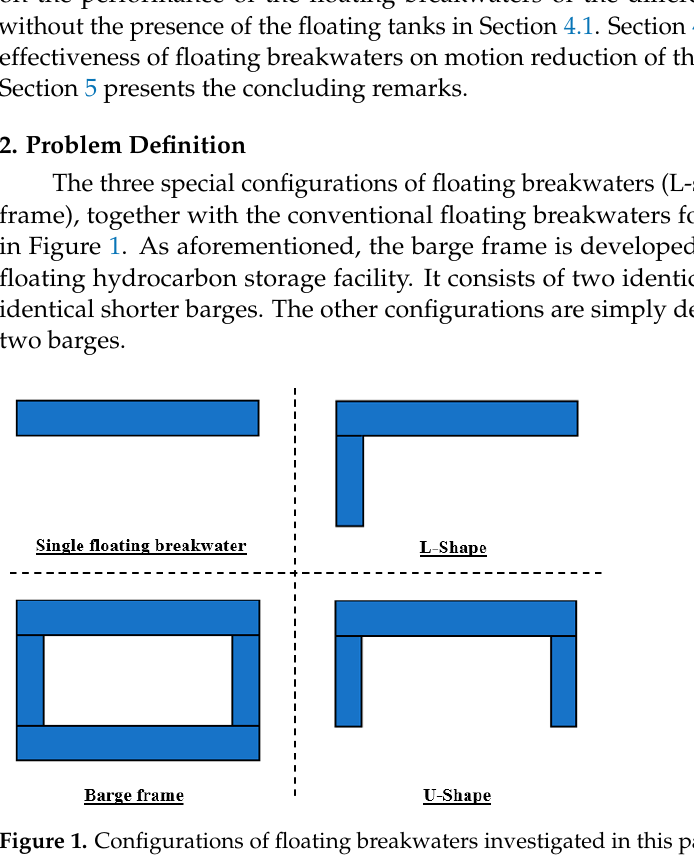
Figure 1. Configurations of floating breakwaters investigated in this paper.